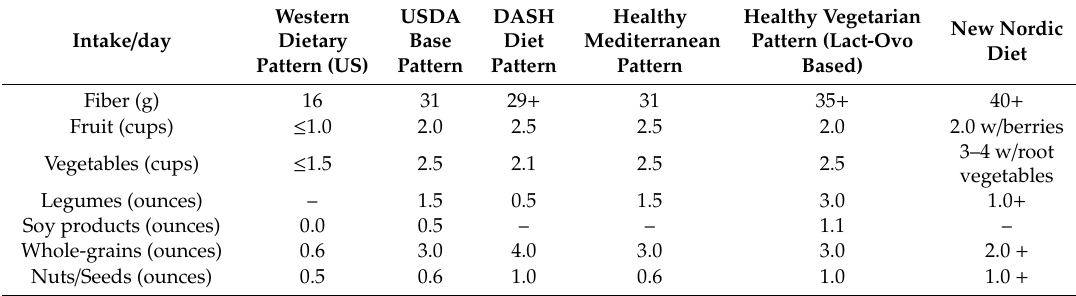
Table 1. Comparison of the dietary fiber content and its food sources for Western vs. healthy diets per 2000 kcals (approx. values)